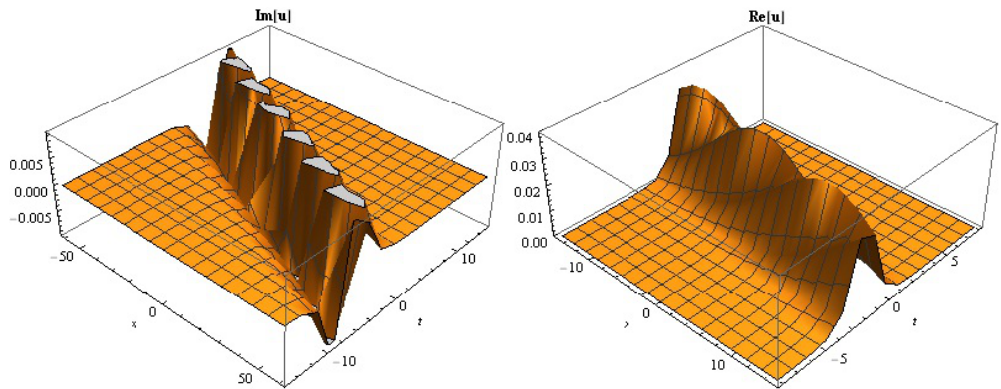
Figure 1. The 3D figures of u 1 for k = 0.1, w = 2, ε = 1, α = 0.4,, α 1 = 0.3, α 2 = 4, α 3 = 0.5, y = 0.05.